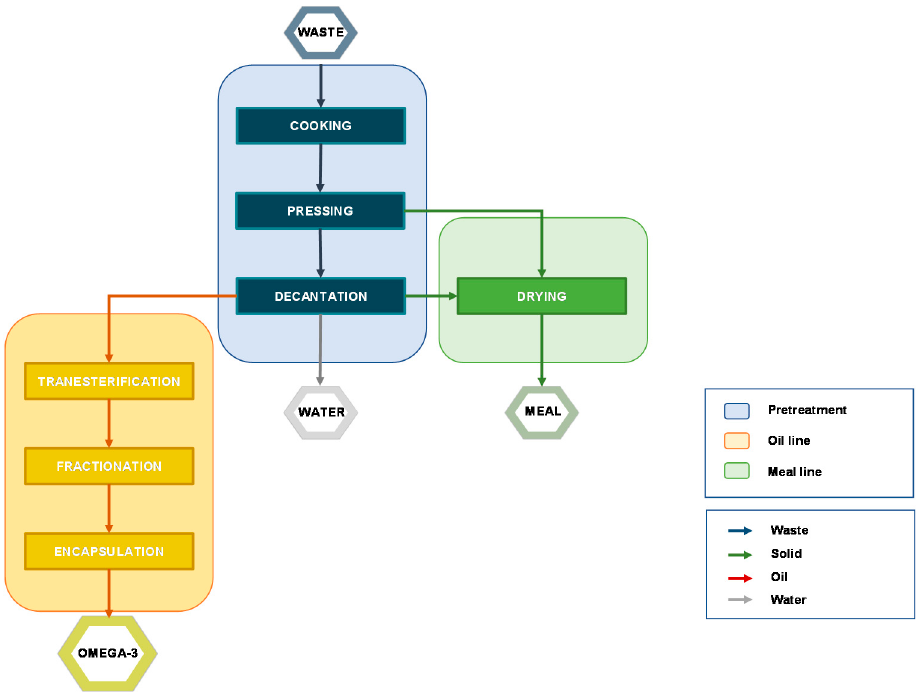
Figure 3. Block flow diagram (BFD) of a typical process from fish waste to final products.